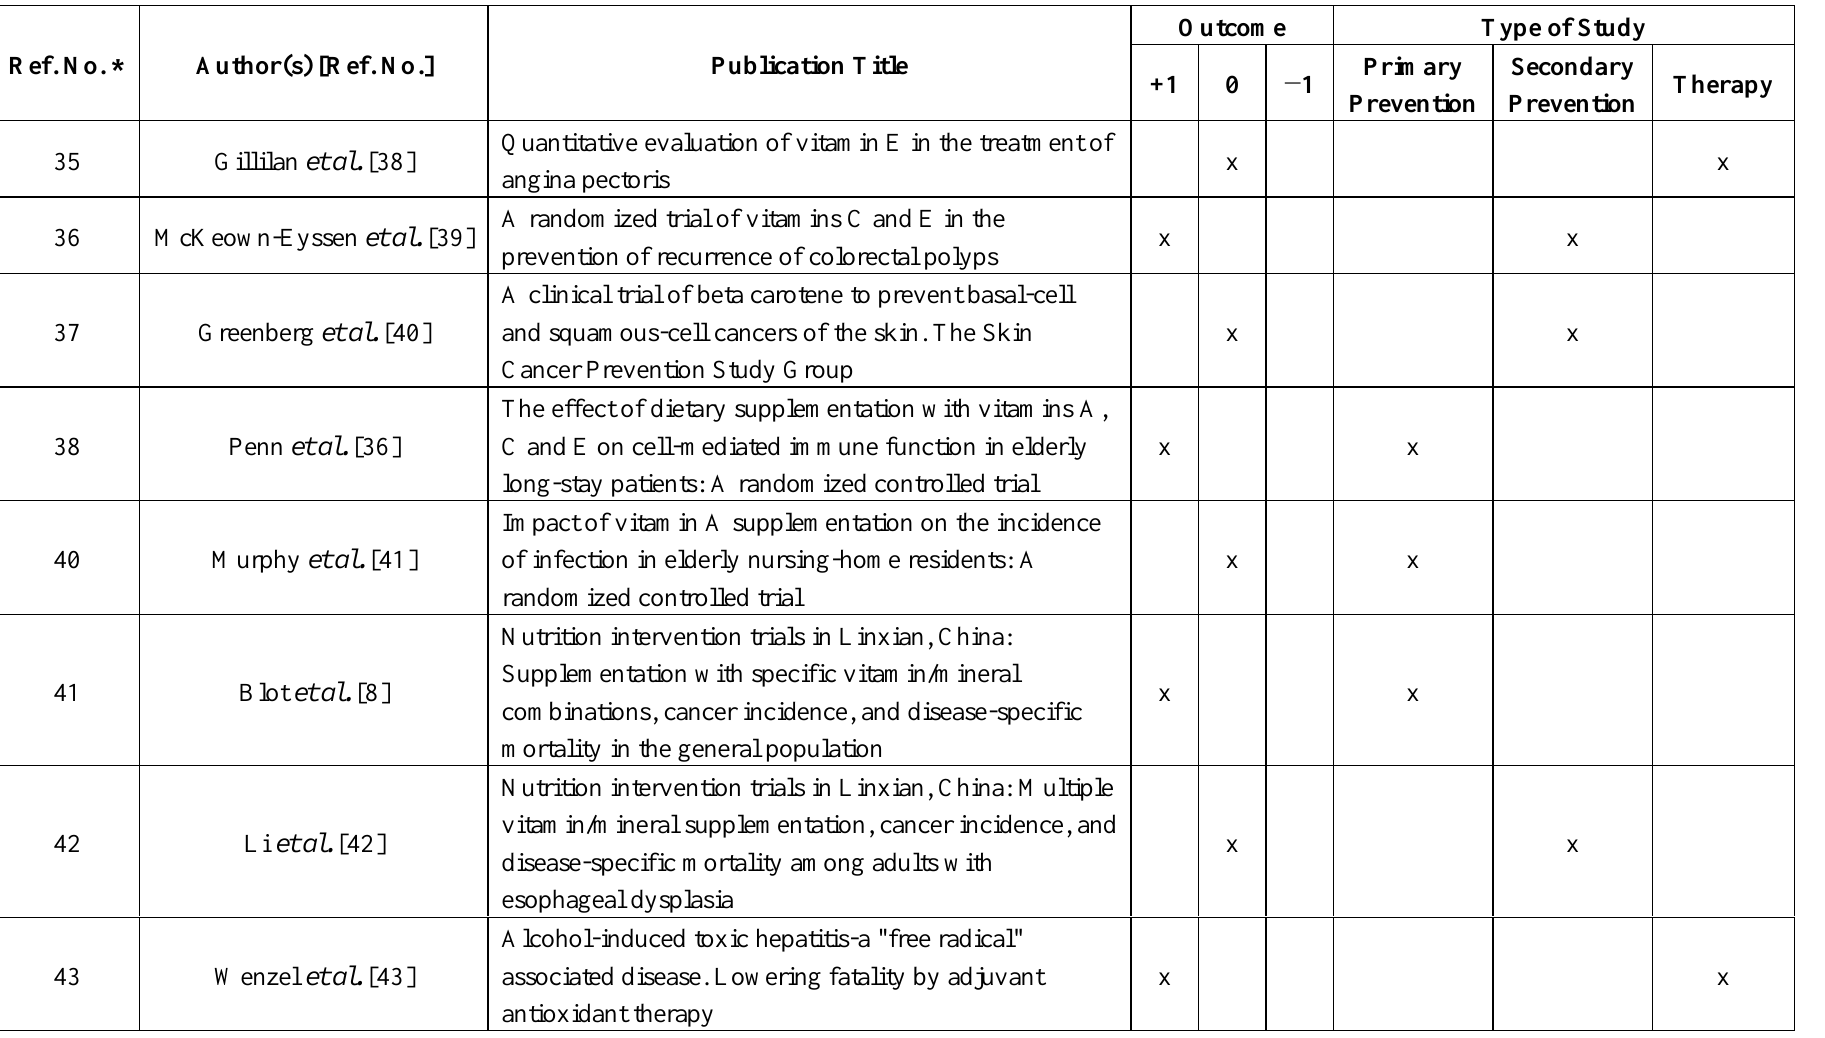
Table 2. Studies of Bjelakovic et al. [27] and their outcome with respect to the study type. Ref. No.